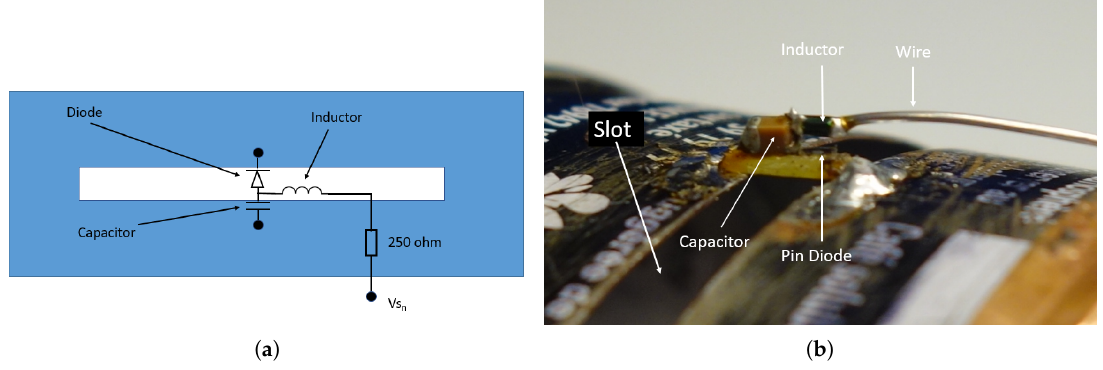
Figure 6. ( a ) Schematic and ( b ) zoom picture on the switching module placed in the